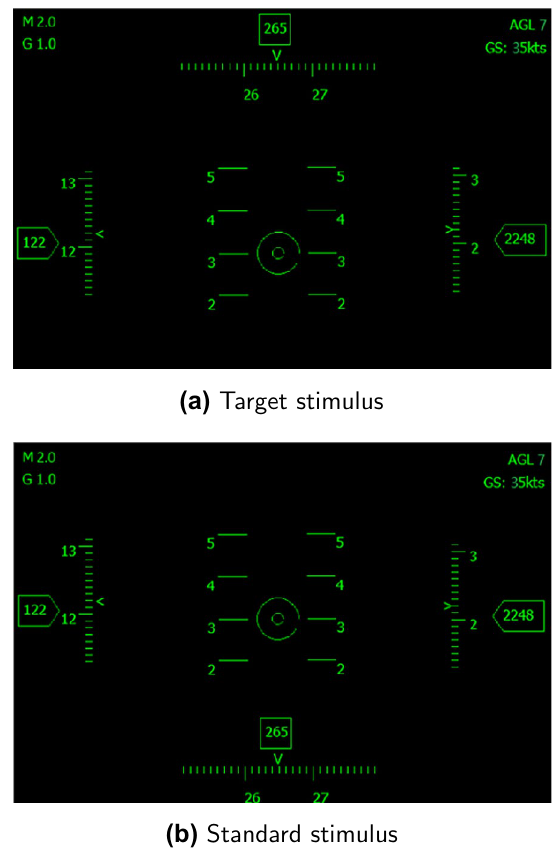
Fig. 2 Indicating interface in the experiment. Target stimulus means that when subjects see the interface, they should click the left mouse button as soon as possible. Standard stimulus means that subjects do not have to react when they see the interface. The interface is only used as instruction at the beginning, and the corresponding text information will not appear during the experiment